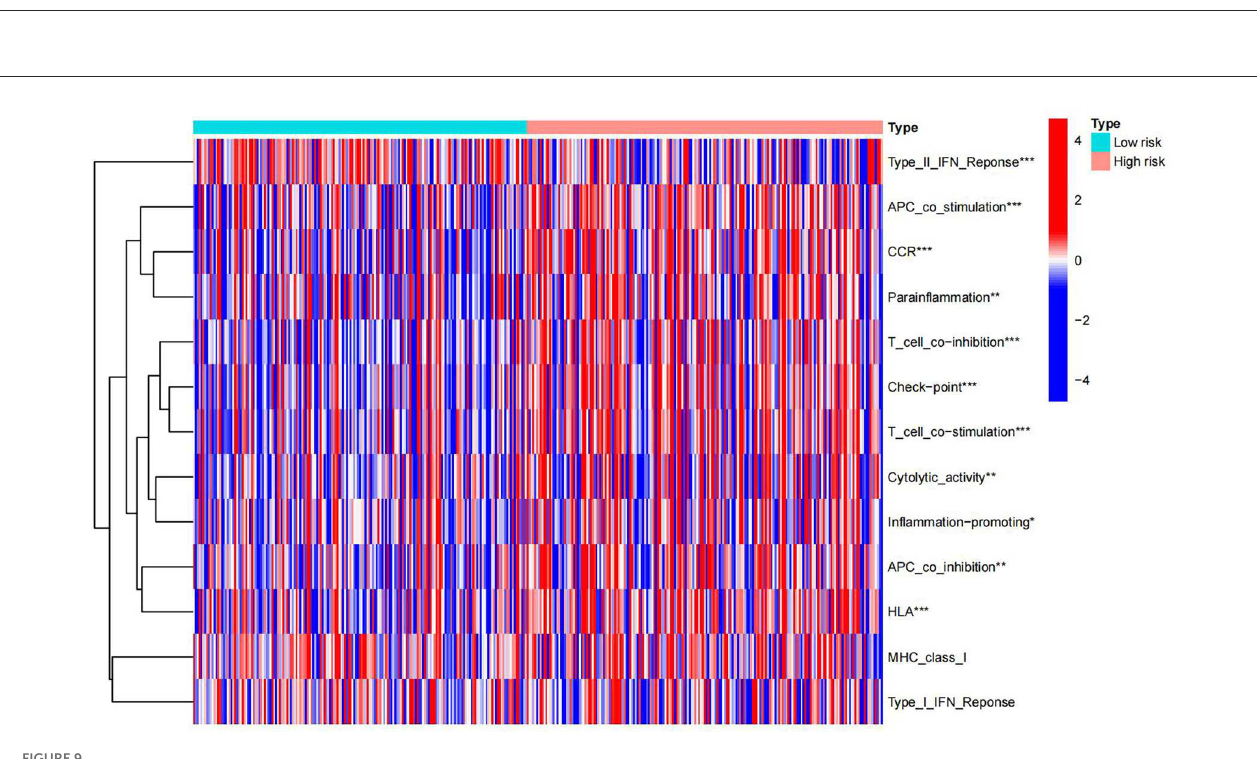
FIGURE9 Immune enrichment analysis heat